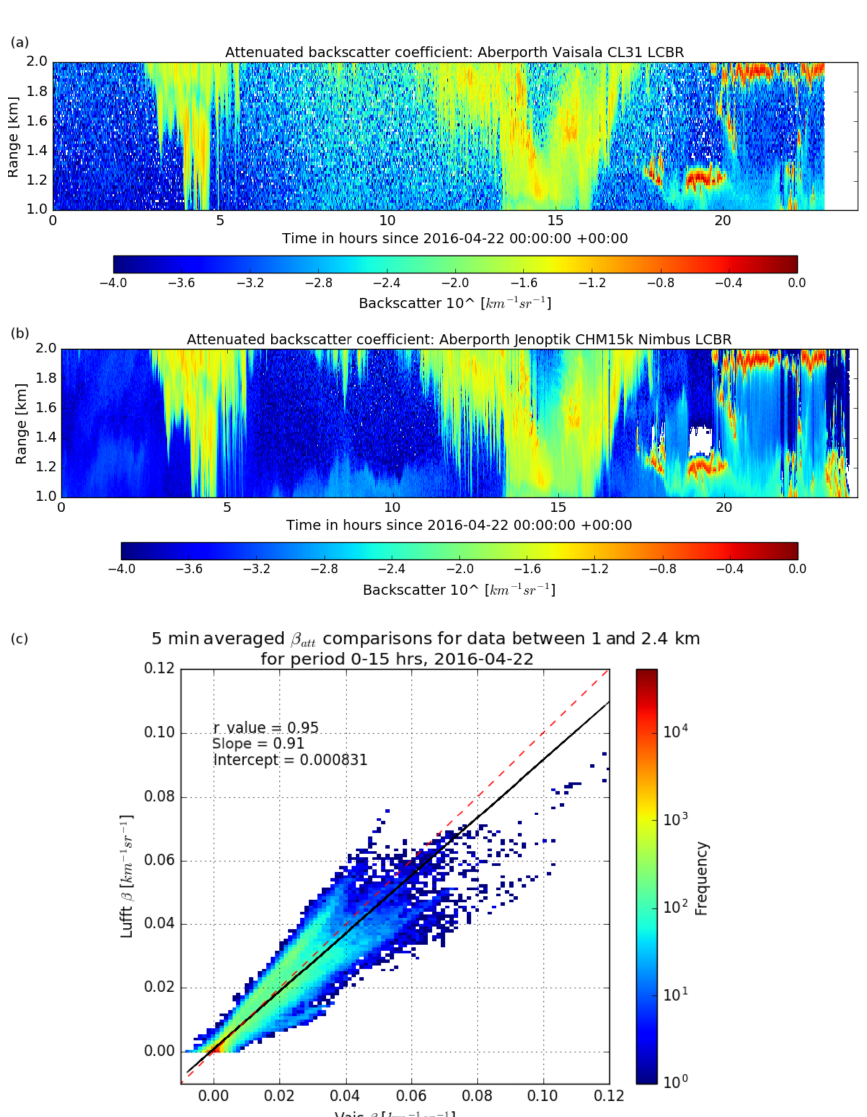
Figure 14. Quicklooks for the observed attenuated backscatter between 1 and 2km are shown for the (a) Vaisala ceilometer and the (b) Lufft ceilometer. Panel (c) shows 5min averaged attenuated backscatter comparison for the Lufft and Vaisala ceilometers situated at Aberporth for 22 April 2016 between 00:00 and 15:00GMT. The colour scale indicates the number of data points. Vaisala data have been corrected for water vapour attenuation and difference in wavelength and have been interpolated to match the resolution of the Lufft ceilometer. The black line shows the linear fit of the data and the dashed red line is the 1 : 1